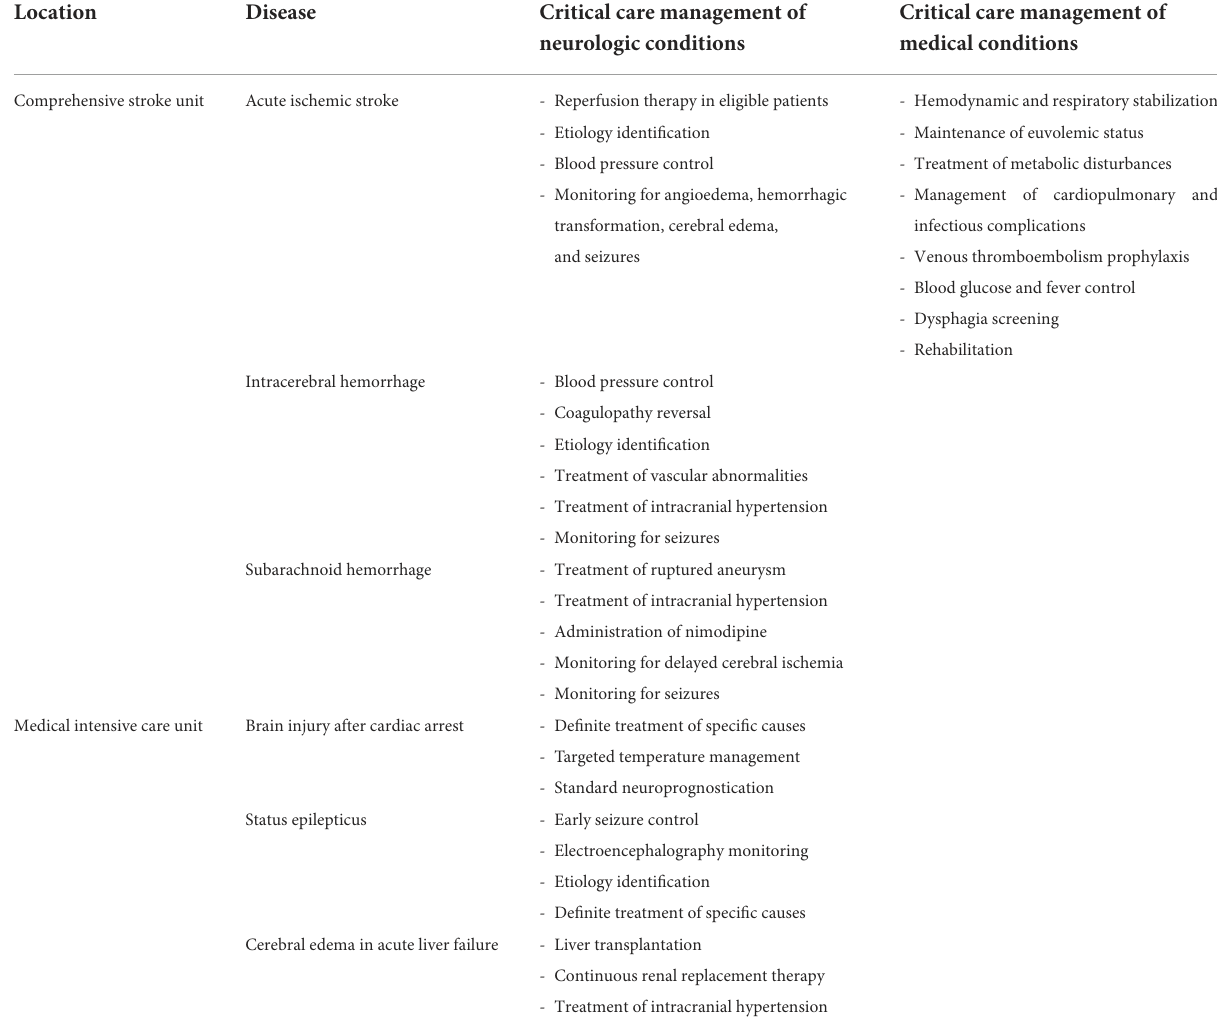
TABLE 1 Practical implementation of neurocritical care for the common neurologic